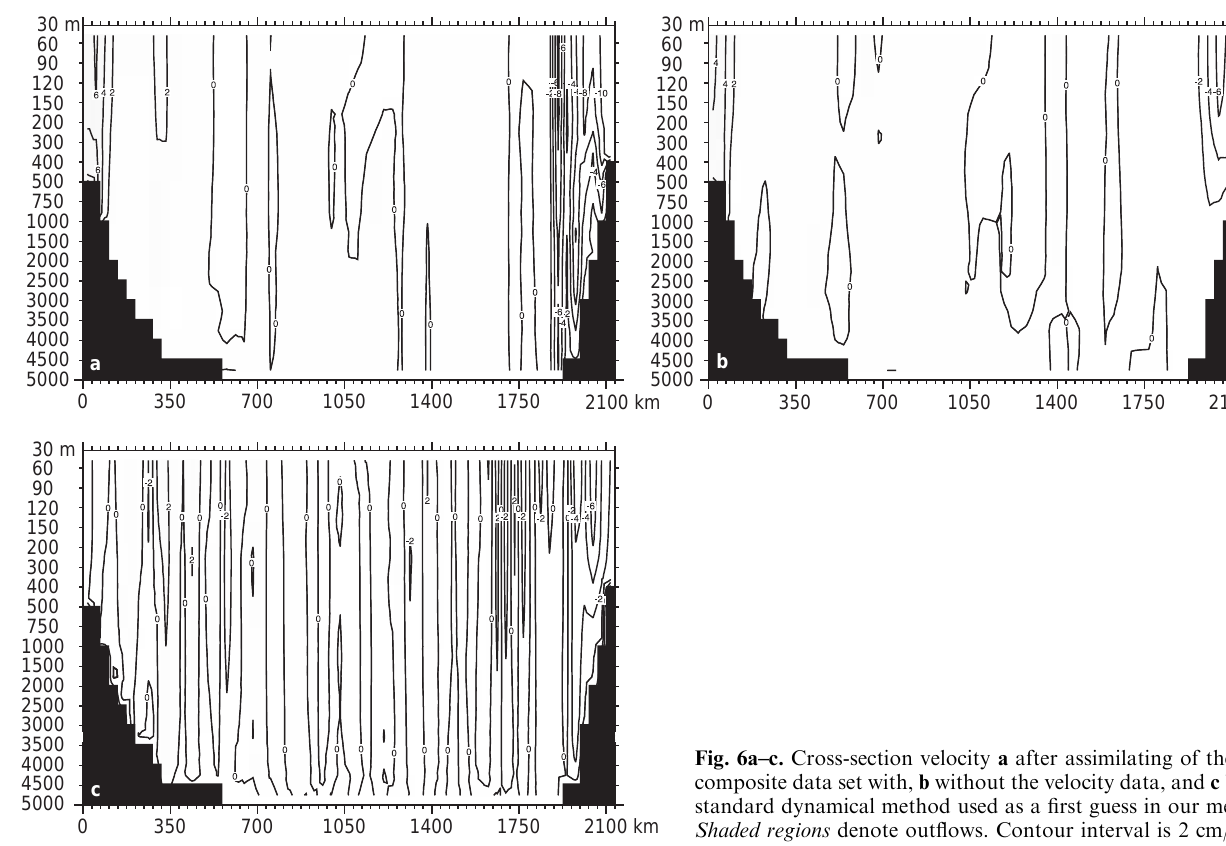
Fig. 6a–c. Cross-section velocity a after assimilating of the composite data set with, b without the velocity data, and c by the standard dynamical method used as a first guess in our method. Shaded regions denote outflows. Contour interval is